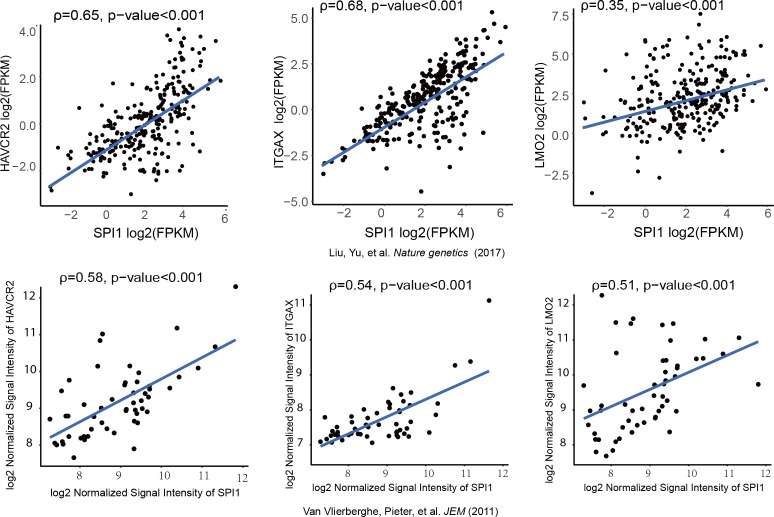
SPI1 expression is positively correlated with HAVCR2, ITGAX and LMO2 expression in human T-ALL.Correlation of SPI1 expression with HAVCR2, ITGAX and LMO2 expression in two different cohorts of human T-ALL samples， ρ: Spearman’s rank correlation coefficient, p-value: p-value of Spearman’s rank correlation test.